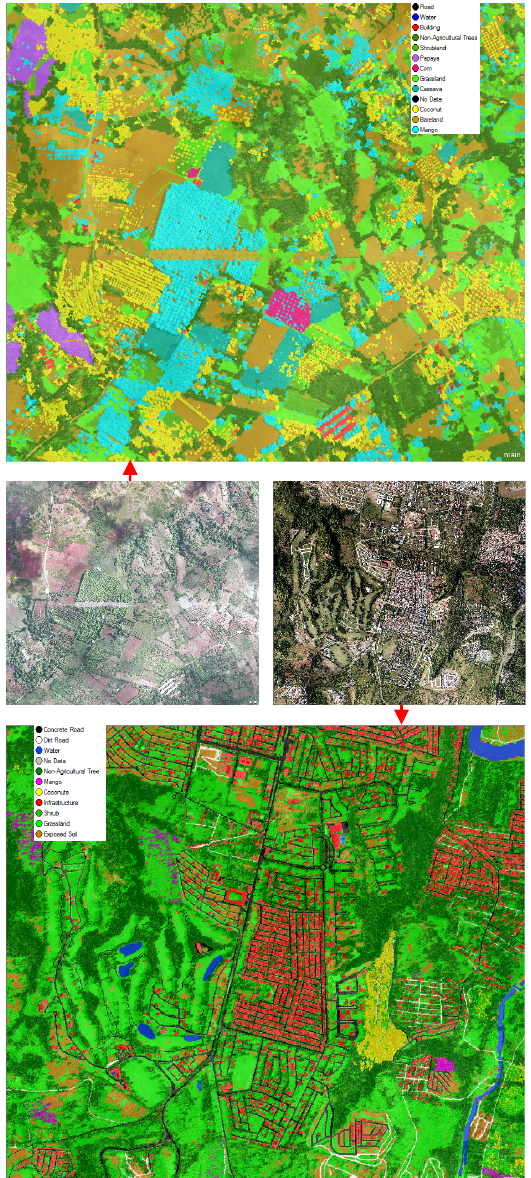
Figure 8. Classification result from two separate municipalities (Libertad and Gitagum) with contrasting illumination (having cloud shaded portions).